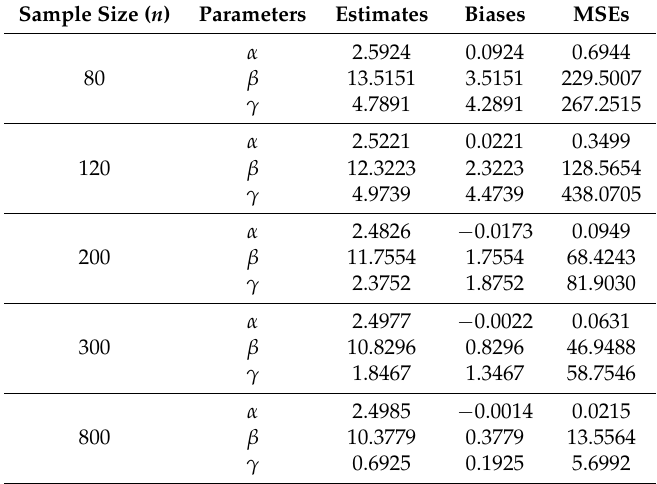
Table 4. Average MLEs, biases and MSEs for α = 2.5, β = 10 and γ = 0.5.